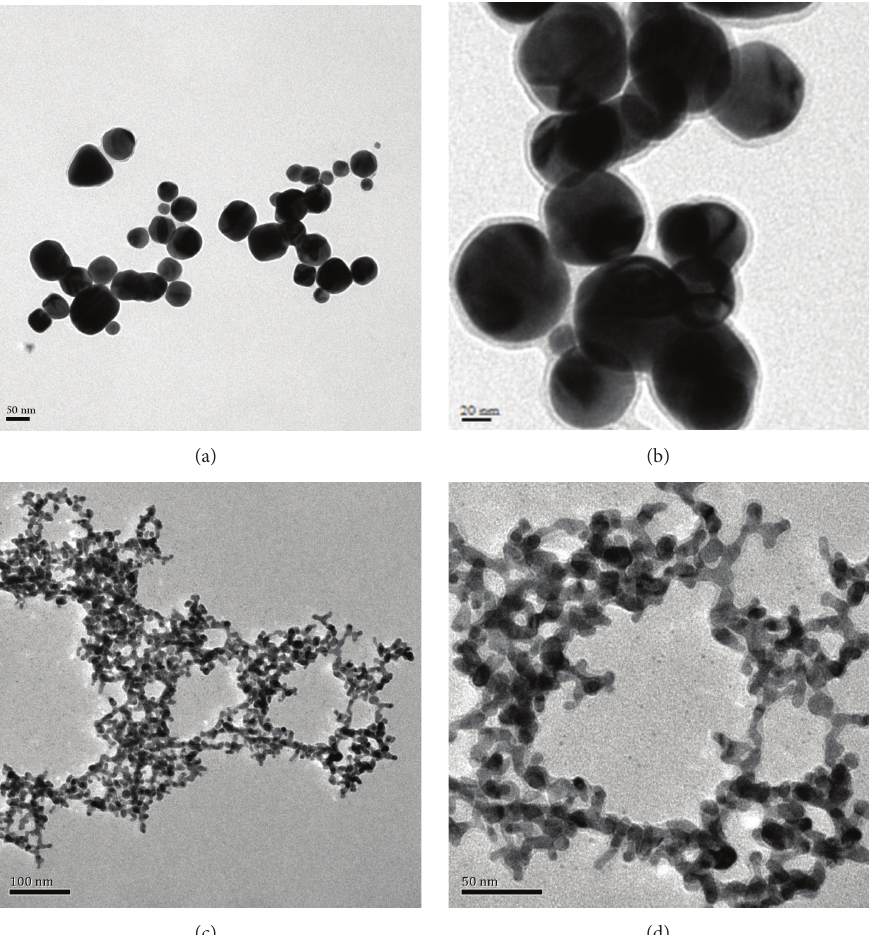
Figure 5: Typical TEM images of Pd-Cu alloys with different magnifications collected under the same conditions, except the variation in the concentration of KOH/EG: (a, b) 0.1 mM and (c, d) 1M.